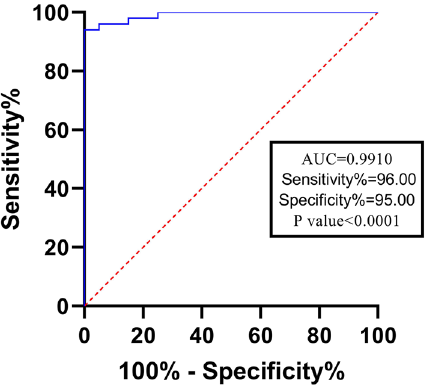
Figure 2. Receiver operative characteristic (ROC) curve of relative expression data for miR-27a with a 0.99 area under the curve illustrates a good differential marker for diagnosing systemic sclerosis patients. P-value = 0.0001, 95% confidence interval = 0.976 to